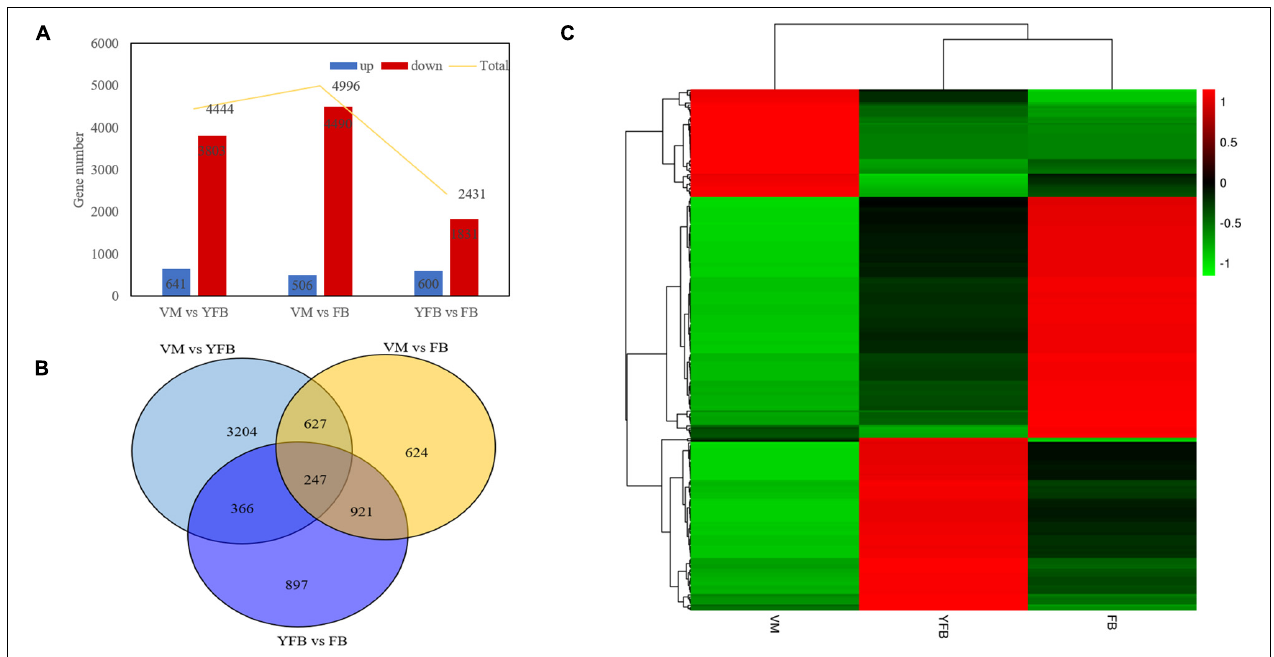
FIGURE 2 | Bar plot, Venn diagram, and heatmap showing co-differentially expressed genes. (A) Bar plot of the differentially expressed genes (DEGs). (B) Venn diagram showing the DEGs exclusive to VM vs. YFB (light blue circle), YFB vs. FB (dark blue circle), and VM vs. FB (yellow circle). (C) Heatmap of co-differentially genes. Red and green colors in the heat-maps represent down- and up- regulated expression levels,